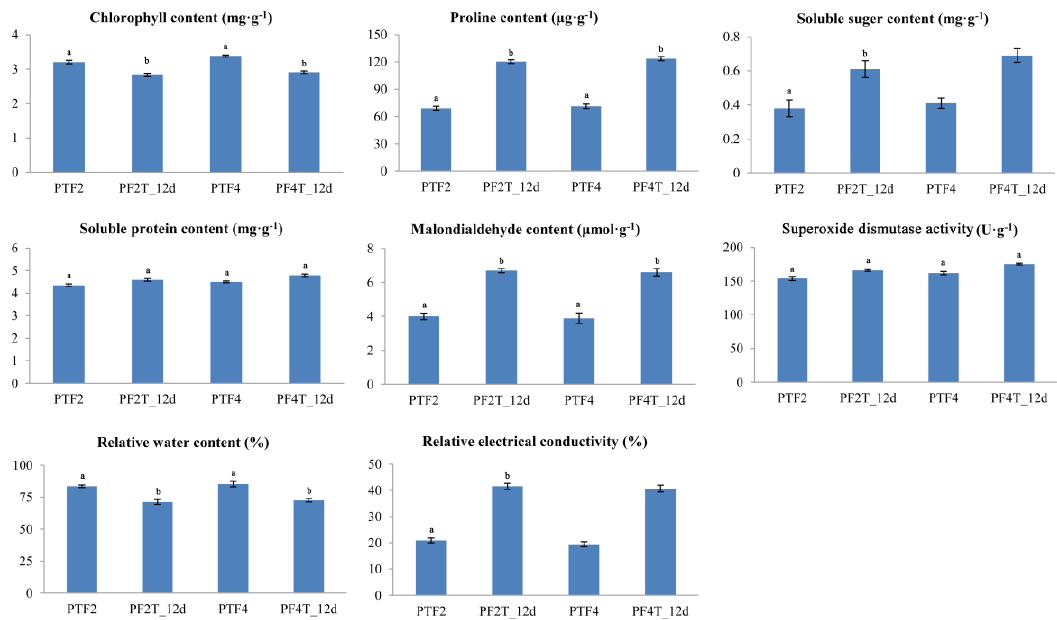
Figure 1. Effects of drought stress on P. fortunei (Seem) Hemsl. physiology. PF2, well-watered diploid; PF2T_12d, 12 days drought-treated diploid; PF4, well-watered autotetraploid; PF4T_12d, 12 days drought-treated autotetraploid. The different letters within a physiological and biochemical index indicate significant difference, while the same letters within a physiological and biochemical index indicate no significant differences ( p < 0.05).